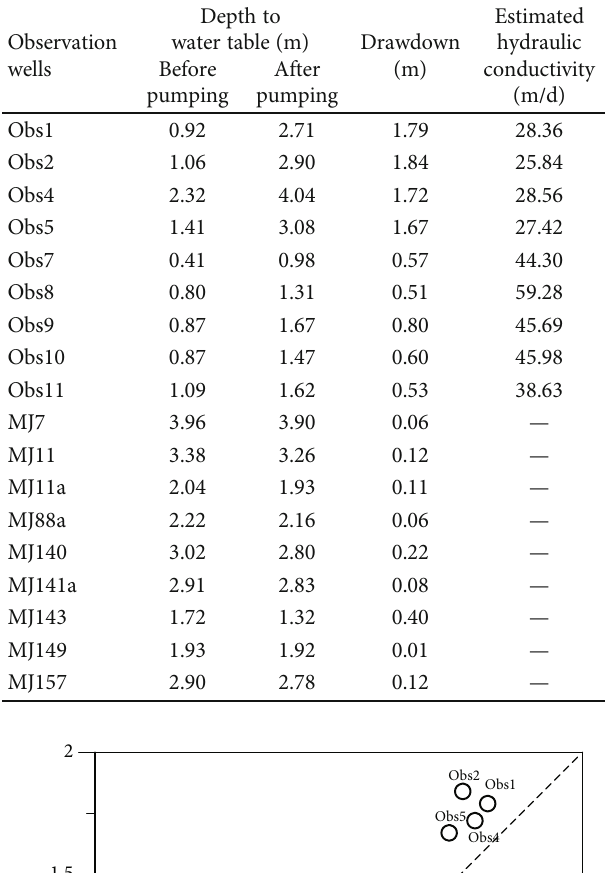
Table 2: Drawdowns of observation wells.